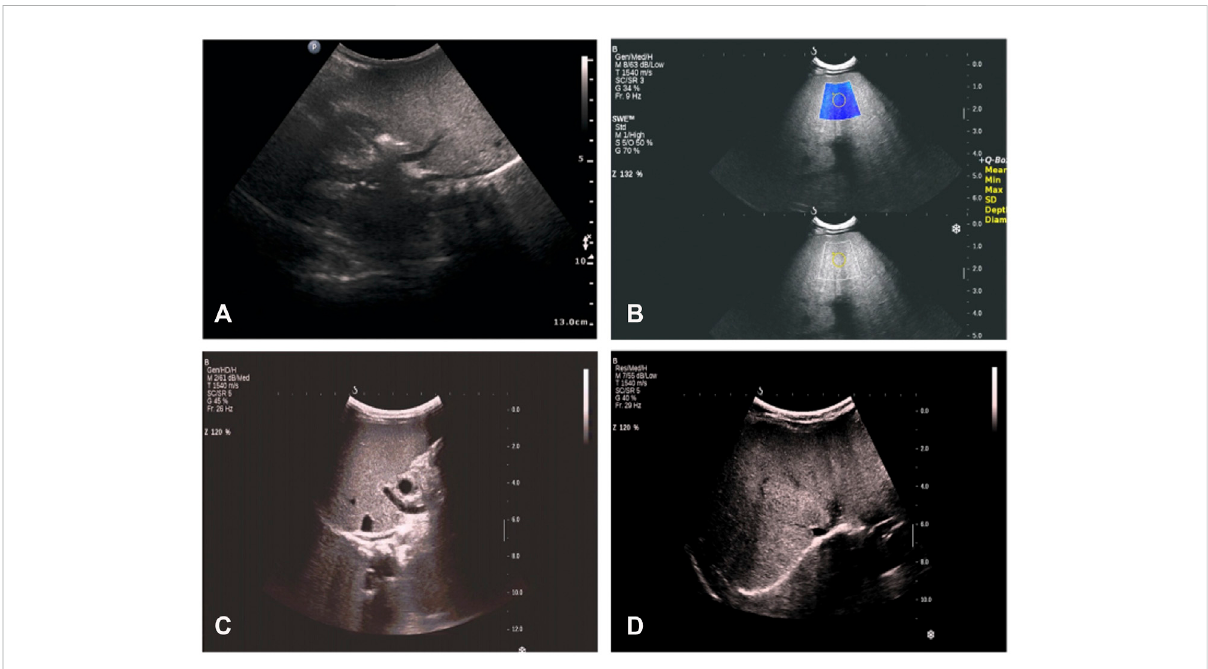
FIGURE 2 Radio fi ndings in proband with glycerol-3-phosphate dehydrogenase 1 (GPD1) mutation from our hospital. (A) at the age of 1 month 26 days: hepatosplenomegaly,thickerparenchymaechospots,slightlycoarsegallbladderwall,andgallbladdercontractionratewaslessthan50%after1 hof breastfeeding. (B) at the age of 2 months 4 days: hepatosplenomegaly, thinner parenchyma echo spots, strengthened echo, thicker and coarse gallbladder wall, and liver tissue elastic modulus was approximately 15 kPa. (C) at the age of 7 months 10 days: hepatosplenomegaly, stronger and diffused echo, and liver tissue elastic modulus was approximately 17 kPa. (D) at the age of 1 year and 4 months: fatty liver change; no obvious abnormality of gallbladder, pancreas, liver, and spleen; liver tissue elastic modulus was approximately 14.3